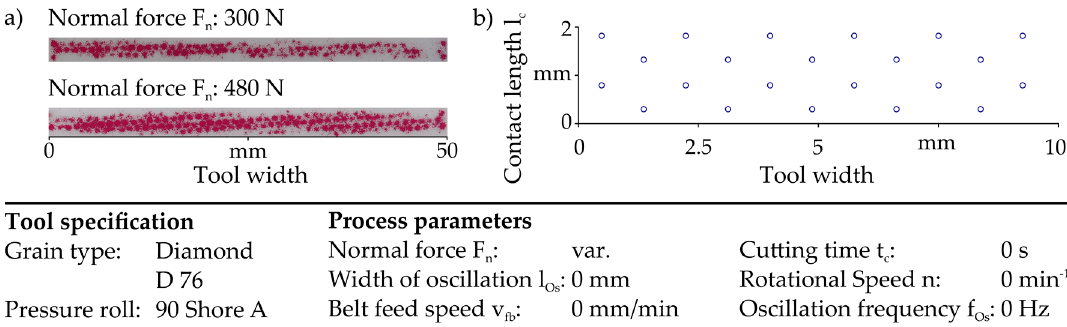
Figure 2. Contact conditions. ( a ) Static contact measurement; ( b ) modelled tool.